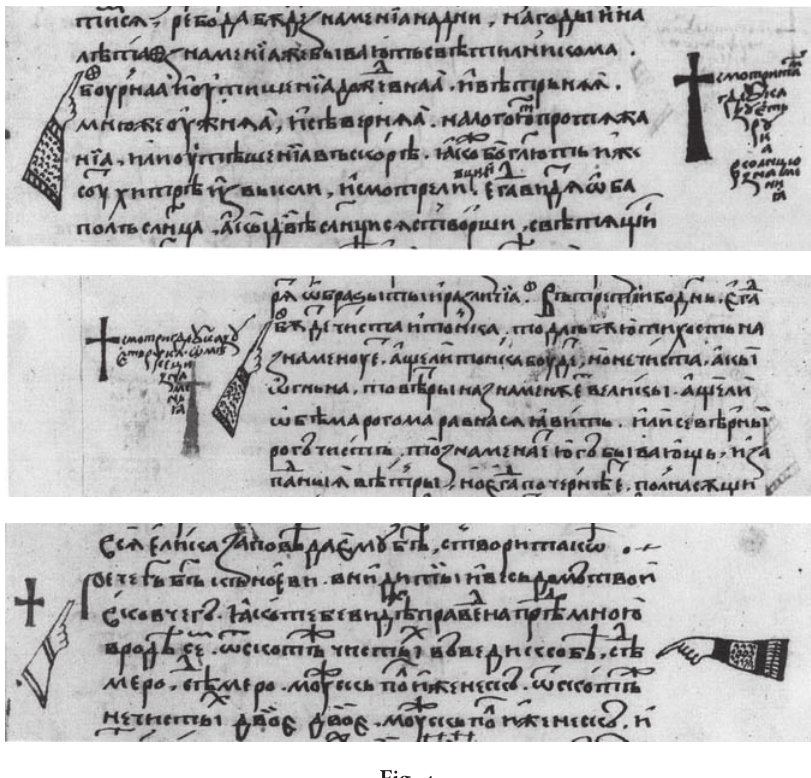
Fig. 4 Manicules in the Xronograf of Vilnius (fol. 6, 6v,